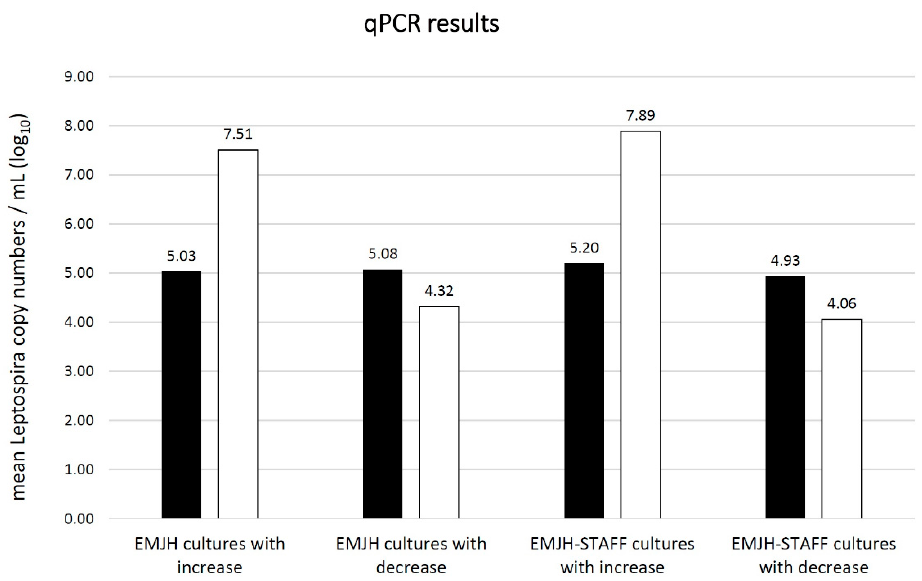
Figure 5. Mean absolute Leptospira copy numbers per mL (log 10 ) as estimated by qPCR in EMJH and EMJH-STAFF cultures with Leptospira copy number increase and decrease ■ 2 days (n = 30 EMJH cultures; n = 30 EMJH-STAFF cultures) compared to □ 28 days (n = 14 EMJH cultures; n = 30 EMJH-STAFF cultures) post inoculation.